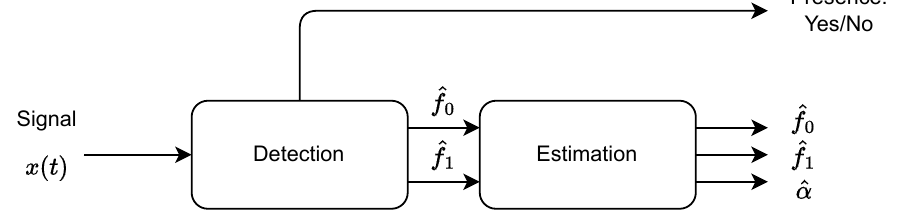
Figure 8. Hybrid detection/estimation